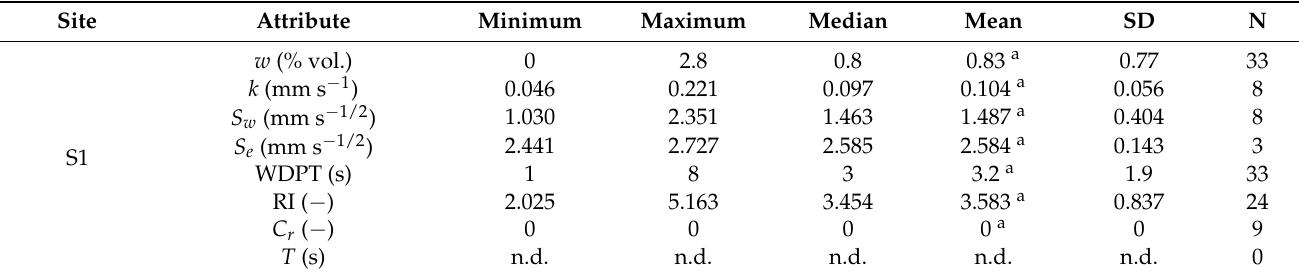
Table 2. Statistical characteristics of soil properties (namely the volumetric water content, w , hydraulic conductivity, k ( − 2 cm), water sorptivity, S w ( − 2 cm), ethanol sorptivity, S e ( − 2 cm), water drop penetration time, WDPT, and repellency index, RI) of the top layer of acidic sandy soils from the sites S1, S2, and S3. (SD—standard deviation; N—number of